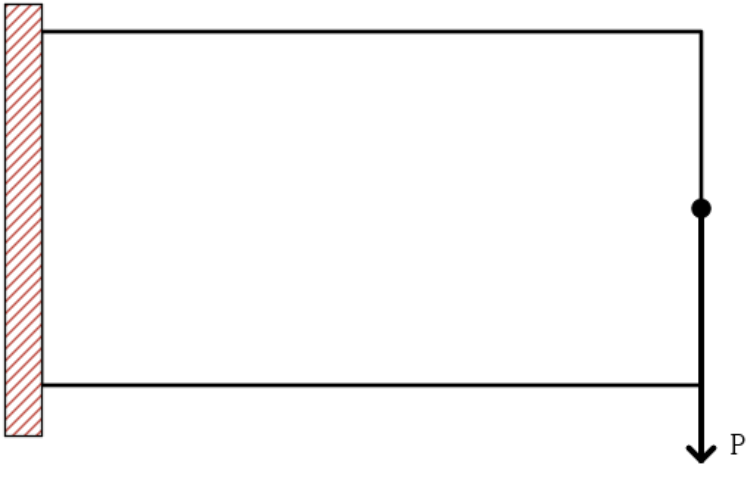
Figure 7. Cantilever beam